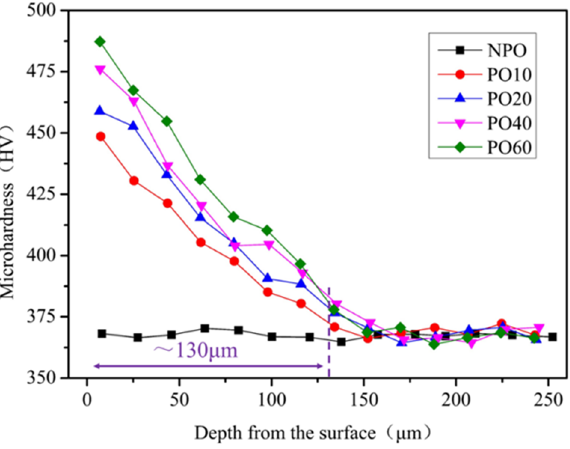
Figure 5. The microhardness distribution near the surface of the oxygen diffusion specimen.